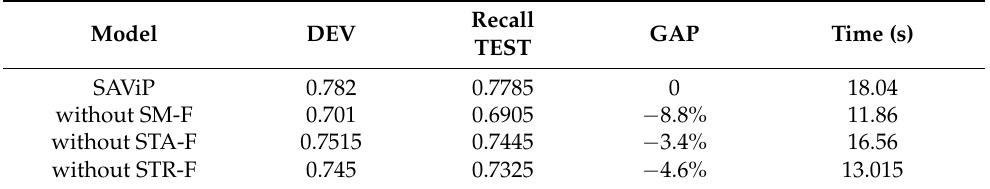
Figure 9. Results of the ablation study. The graph shows that the most significant contribution to our model was made by semantic features. Table 5. Ablation